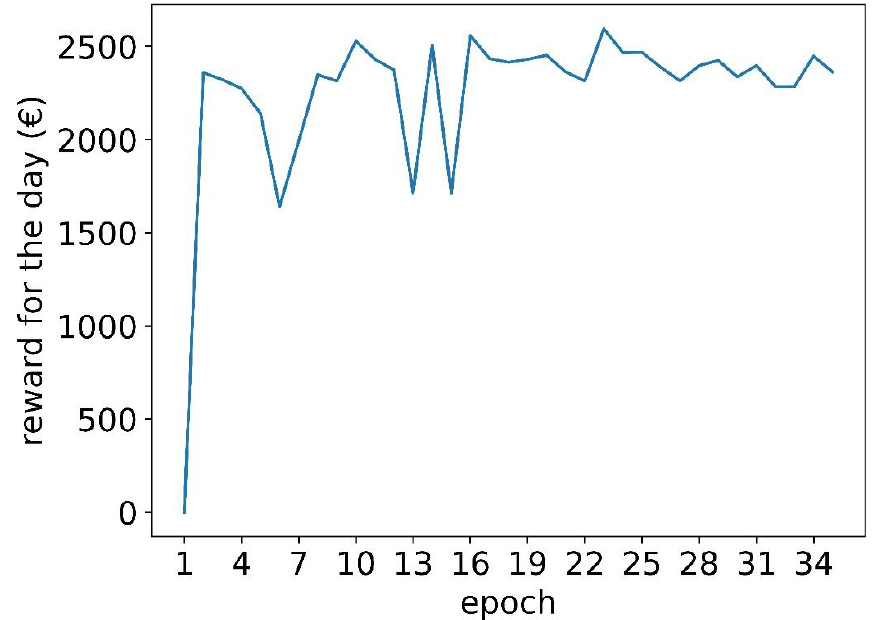
Figure 7. The cumulative reward for all of the training days.